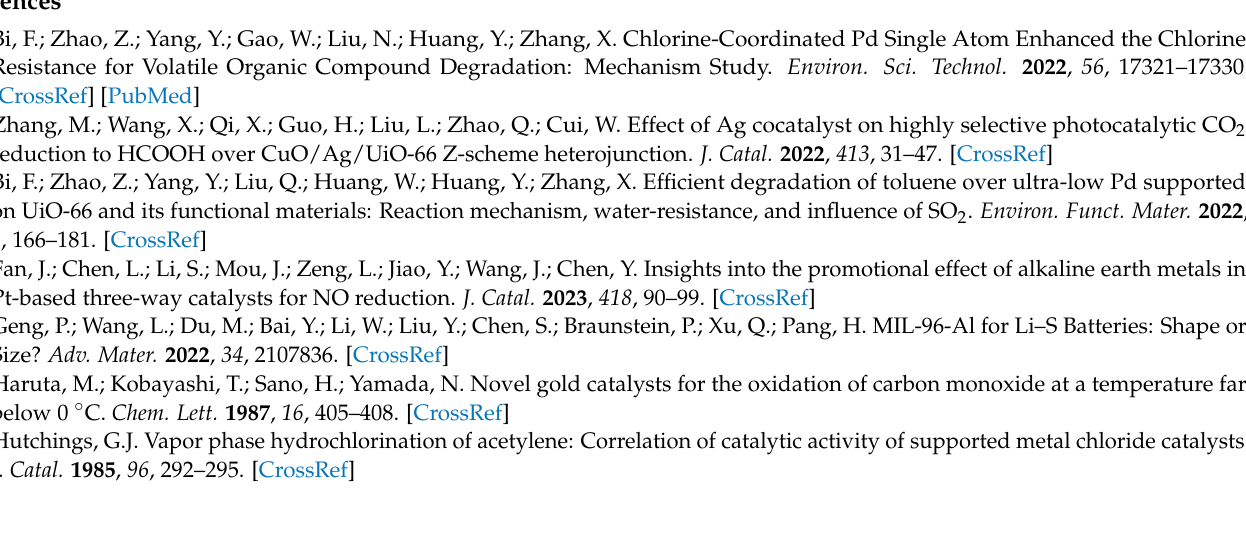
pretreatment; Figure S3: XPS spectrum of the Au/C catalyst with different treatments; Figure S4: XPS spectrum and simulation for the Au/C catalyst with HCl sequence pretreatment (derived from Figure 1d); Figure S5: H 2 -TPR profiles of Au/C with HCl sequence pretreatment; Figure S6: CO-TPD profiles of Au/C and reference C samples with HCl sequence pretreatment; Figure S7: Detected desorption gas signals of Au/C with HCl pretreatment; Figure S8: FTIR profiles of Au/C and Table S2: Bulk phenolic compositions of Au/C catalyst with different pretreatments from CO TPD-MS; Table S3: Reaction energy for proposed Au migration